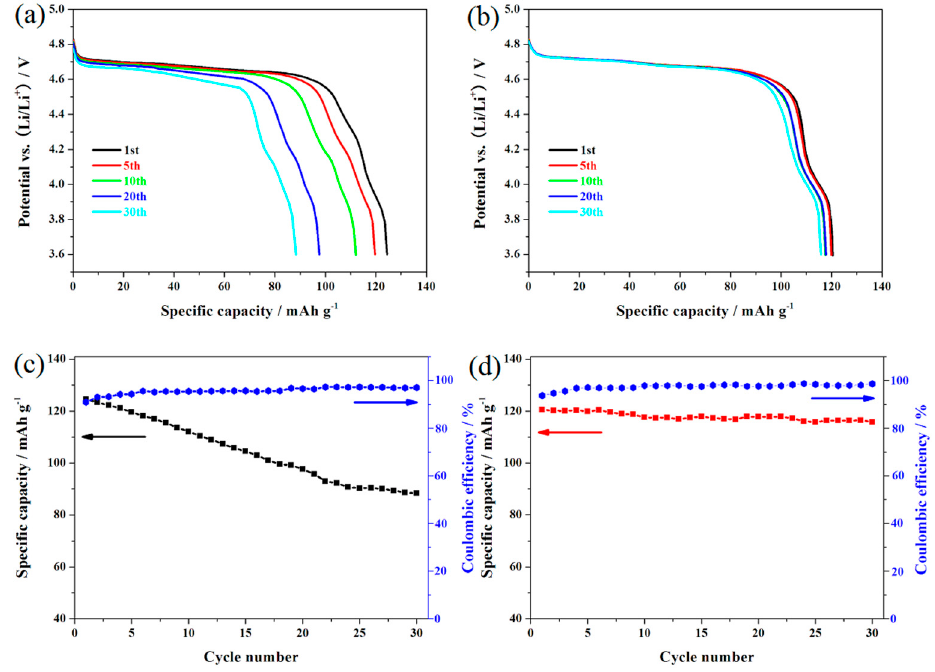
Figure 4. Representative charge/discharge curves of the LiNi 0.5 Mn 1.5 O 4 ( a ) and Er-doped LiNi 0.5 Mn 1.5 O 4 ( b ); cycling performance and coulombic efficiency of the LiNi 0.5 Mn 1.5 O 4 ( c ) and Er-doped LiNi 0.5 Mn 1.5 O 4 ( d ).